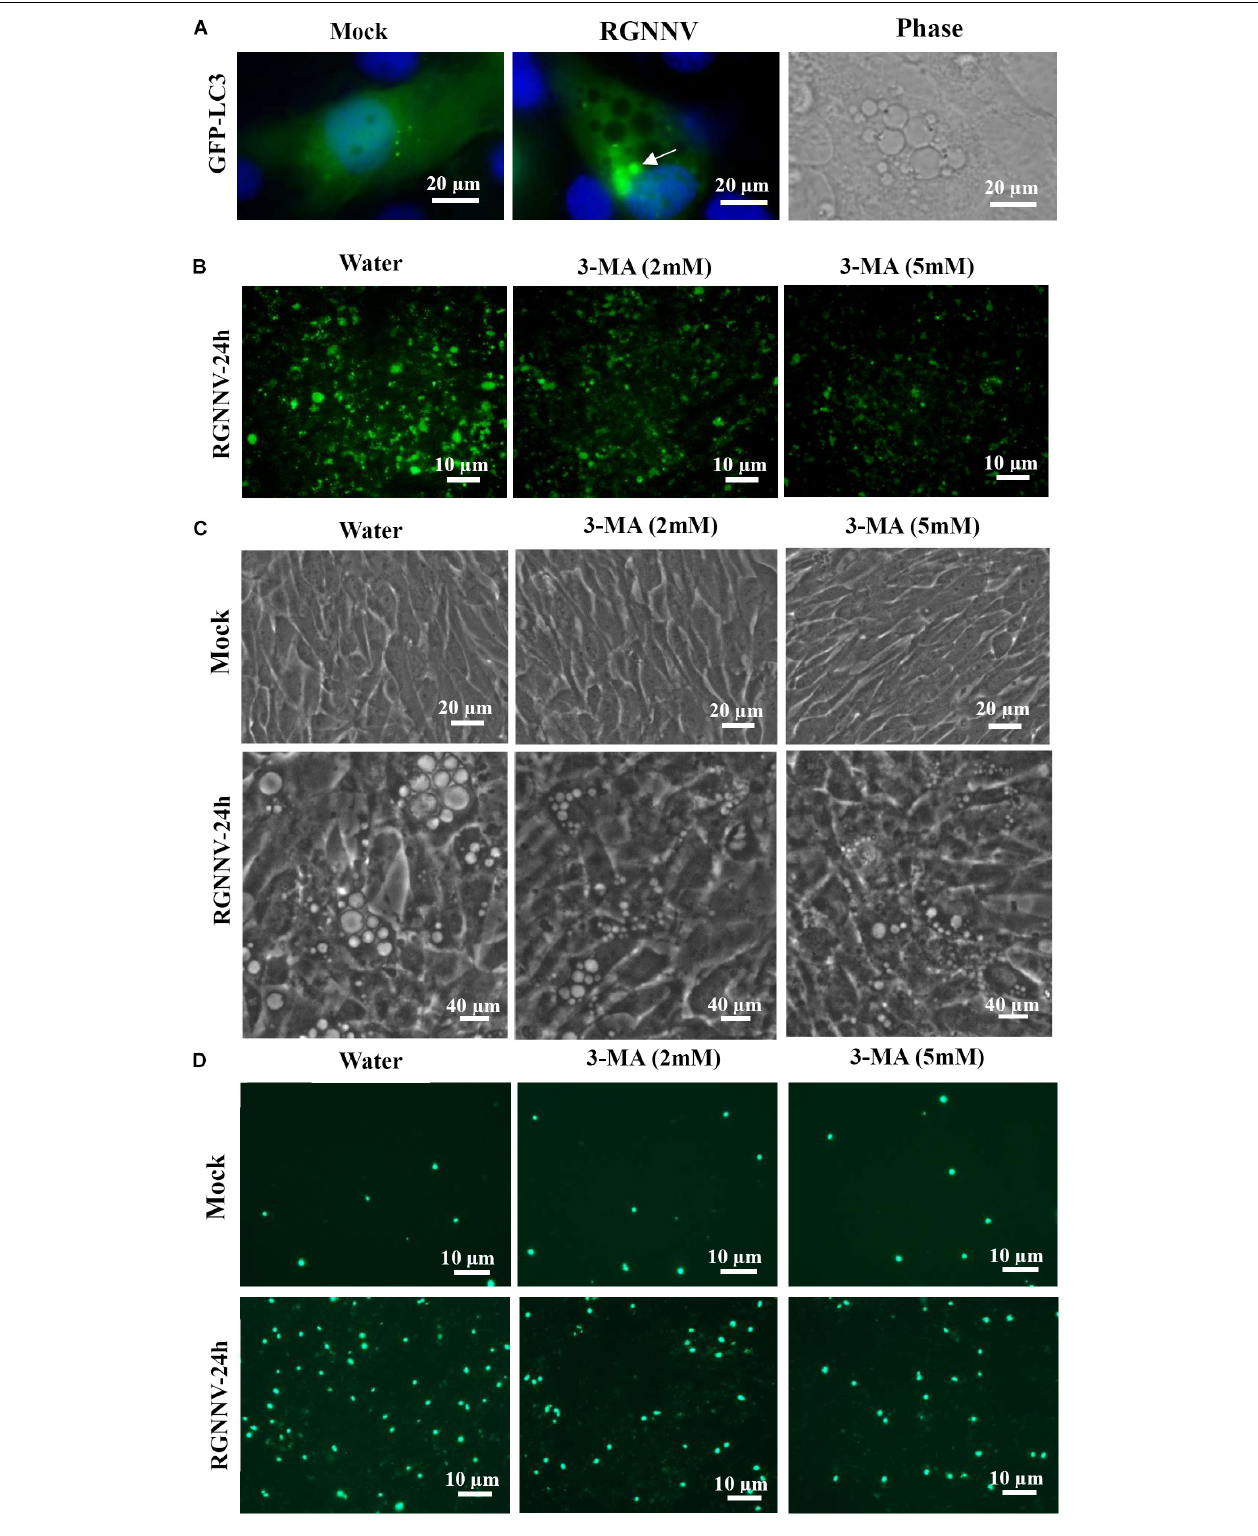
FIGURE 8 | The role of autophagy in vacuole formation during RGNNV infection. (A) The localization patterns of LC3 during RGNNV infection-induced vacuolization. Arrow indicates the LC3 fluorescent puncta. (B) Detection of autophagy in RGNNV-infected cells under treatment with 3-MA. (C) The effects of 3-MA on RGNNV infection-induced vacuolization. (D) The effects of 3-MA on RGNNV infection-induced cell death.